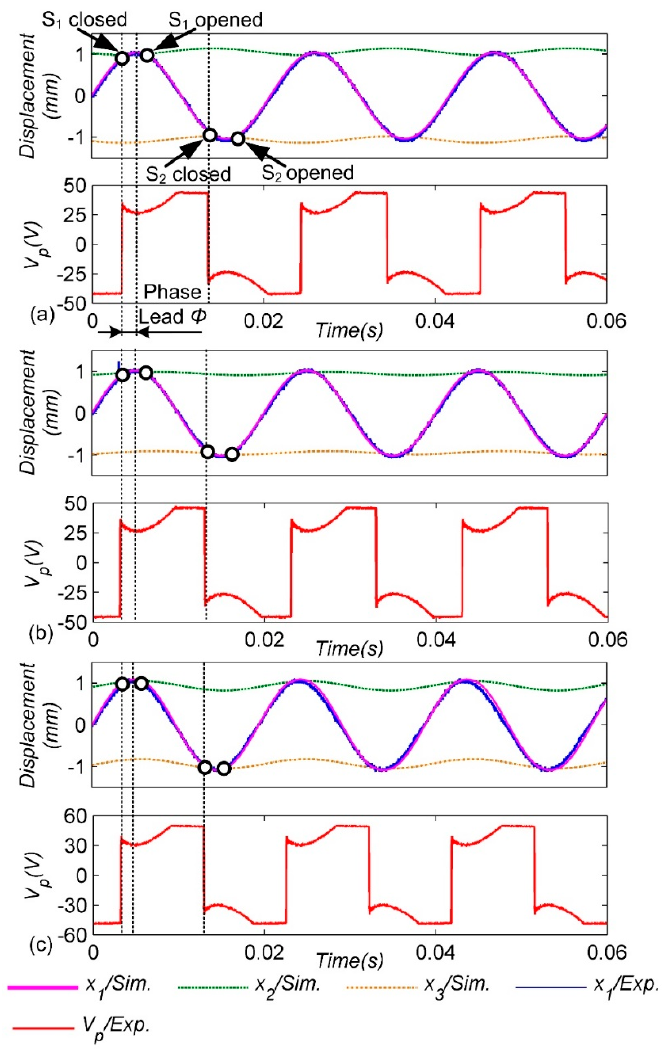
Figure 7. Experimental and simulated waveforms for different excitation frequencies with a constant amplitude A m = 1 mm: ( a ) 48 Hz; ( b ) 50 Hz; ( c ) 52 Hz.